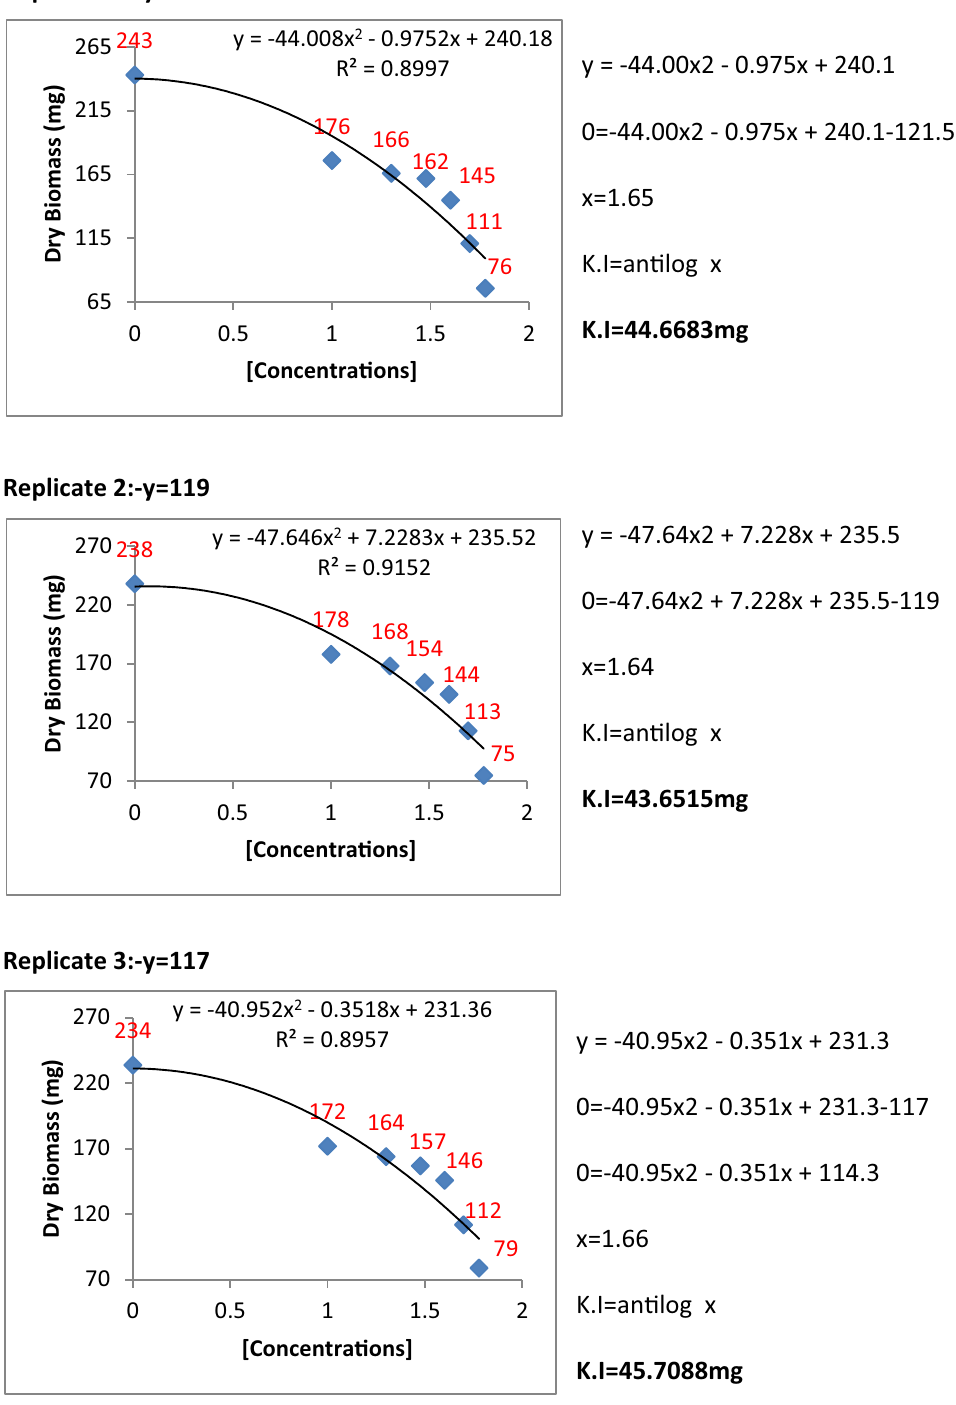
Figure 14. Kinetic constants of inhibition of P. herbarum by metabolites of P. crustosum (3